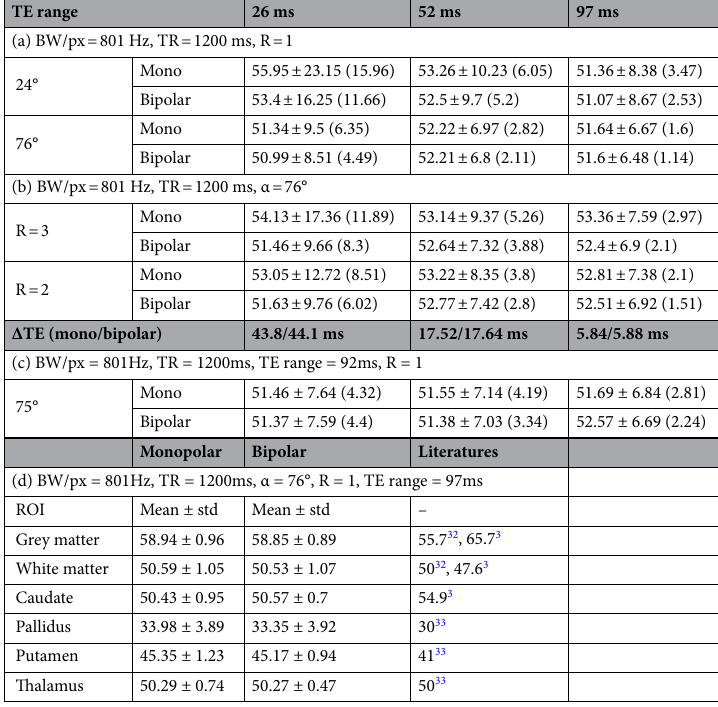
Table 3. Mean, standard deviation, and relative difference of the standard deviation from one healthy volunteer with respect to the (a) α and TE range, (b) R and TE range and (c) ∆TE. The values were measured in white matter. The numbers in parentheses are the standard deviations predicted from CRLB. As in the computer simulation and phantom experiments, standard deviation increases as the α and TE range decrease. (a and b) The difference between both readouts also tends to increase with a decrease in the α and TE range. (c) When monopolar and bipolar readouts have similar TEs, both readouts show comparable precision. (d) The mean and standard deviation averaged across all subjects (number of subjects = 2). The values were calculated from the data with α of 76° and R of 1 for the maximum TE range (i.e., 97